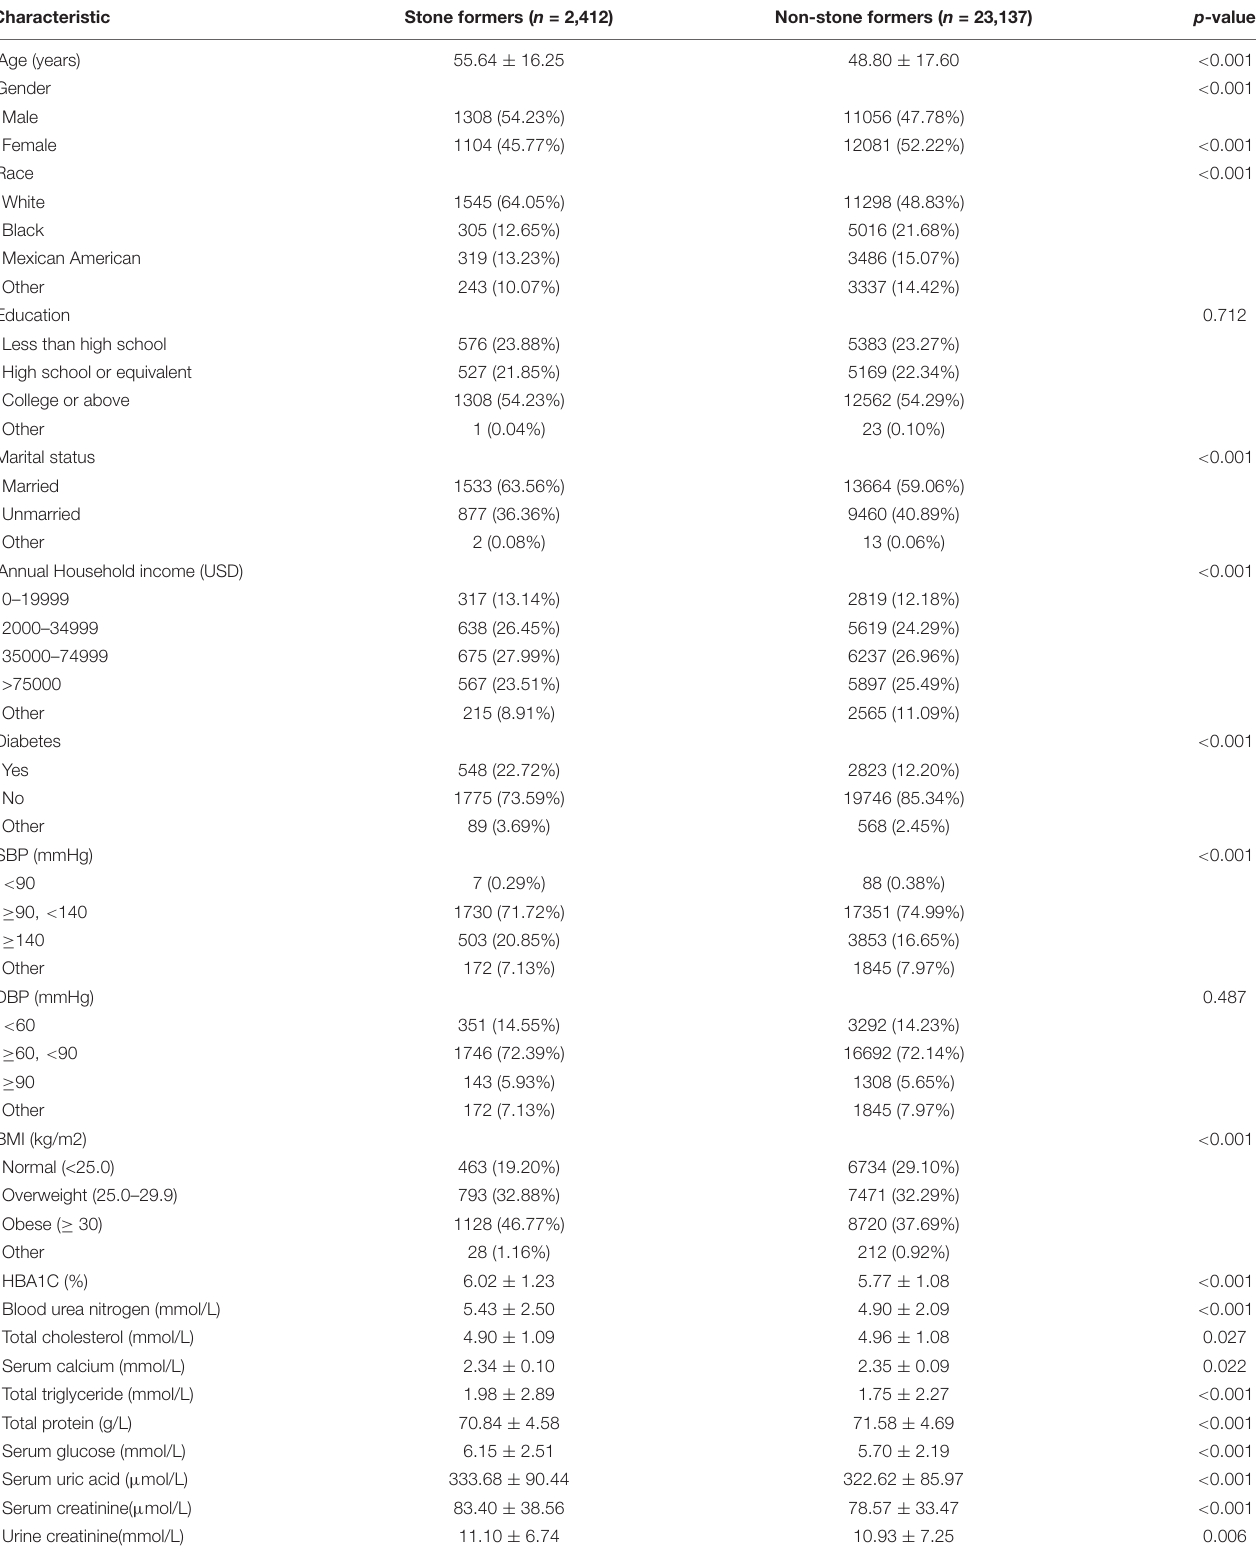
TABLE 1 | Baseline characteristics of US participants in NHANES from 2009 to 2018. Characteristic Stone formers ( n = 2,412) Non-stone formers ( n =